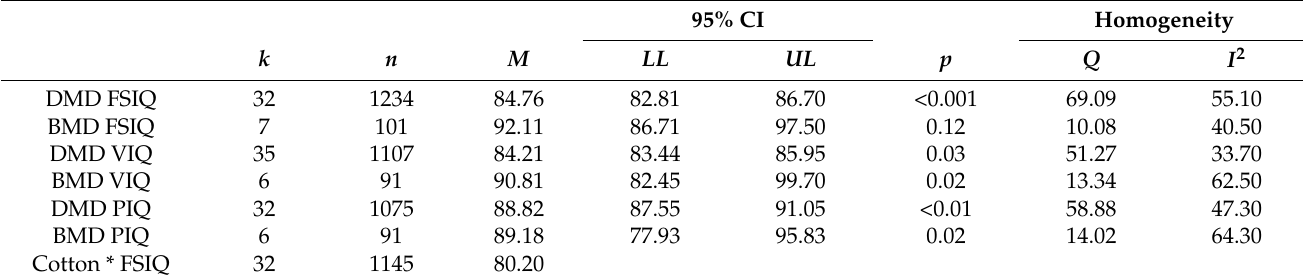
Table 1. Weighted mean effect size meta-analysis.